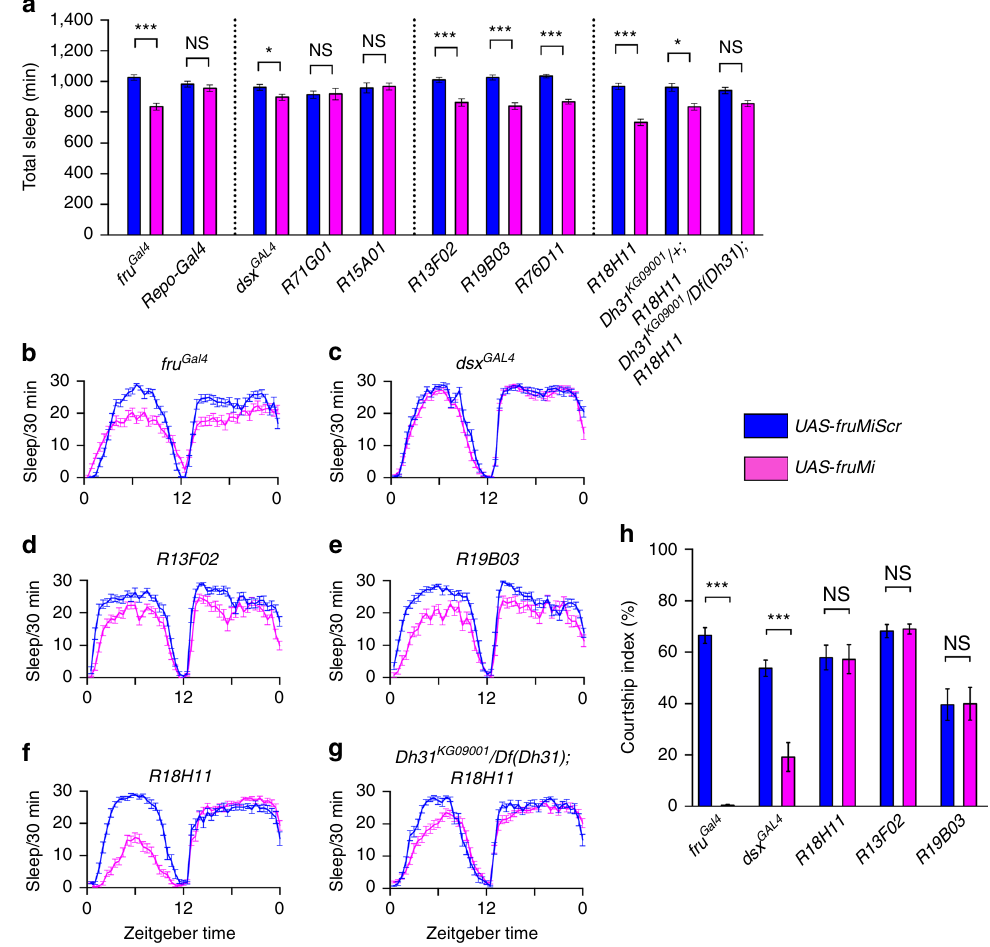
Fig. 9 FRU M differentially regulates courtship and sleep. a Knocking down fru M in MB or DN1 neurons, but not P1 neurons, reduces male sleep, and the function of fru M in DN1 neurons on male sleep is dependent on Dh31. b – g Detailed sleep pro fi le of males with fru M knocked down in all fru M -expressing neurons ( b ), all dsx -expressing neurons ( c ), MB neurons ( d , e ), DN1 neurons ( f ), and DN1 neurons in Dh31-mutated background ( g ). h Knocking down fru M in dsx -expressing neurons but not MB or DN1 neurons impairs male courtship. n = 24~32 for each. * p < 0.05 and *** p < 0.001, unpaired t- test. NS ,